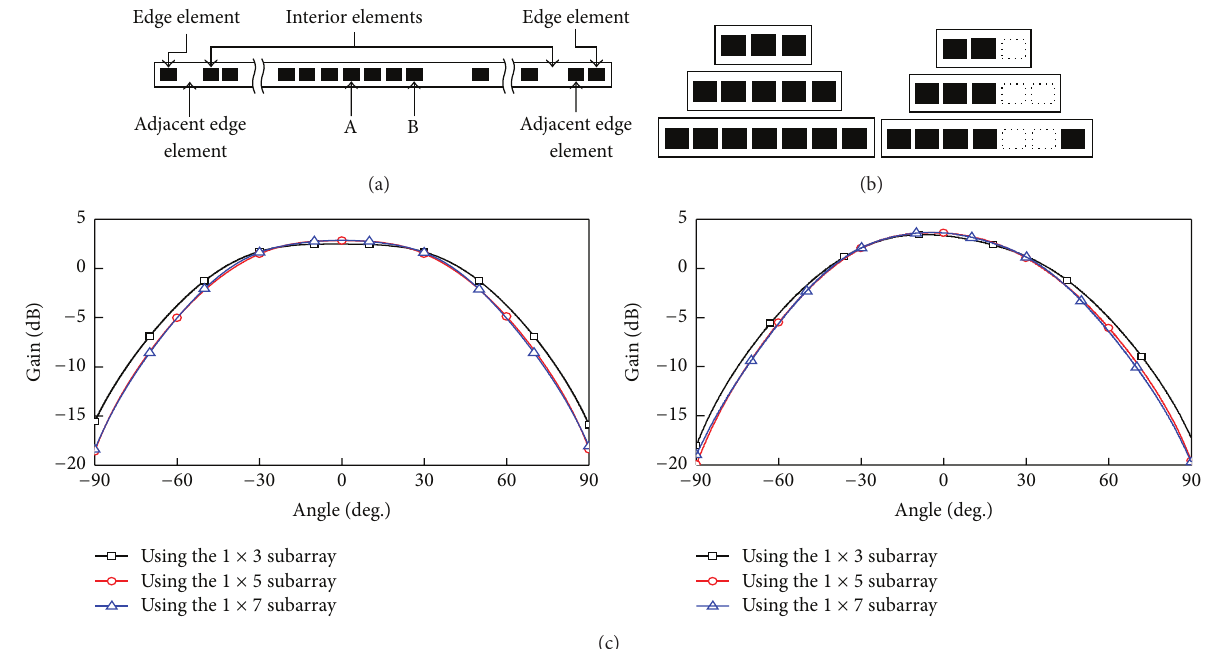
Figure 2: Patch subarrays and their corresponding AEPs. (a) Top view of a thinned linear patch array, (b) subarrays used to extract the AEPs of elements A and B, where a dotted rectangle denotes a position without element and a black rectangle denotes a position with element, and (c) AEPs of elements A and